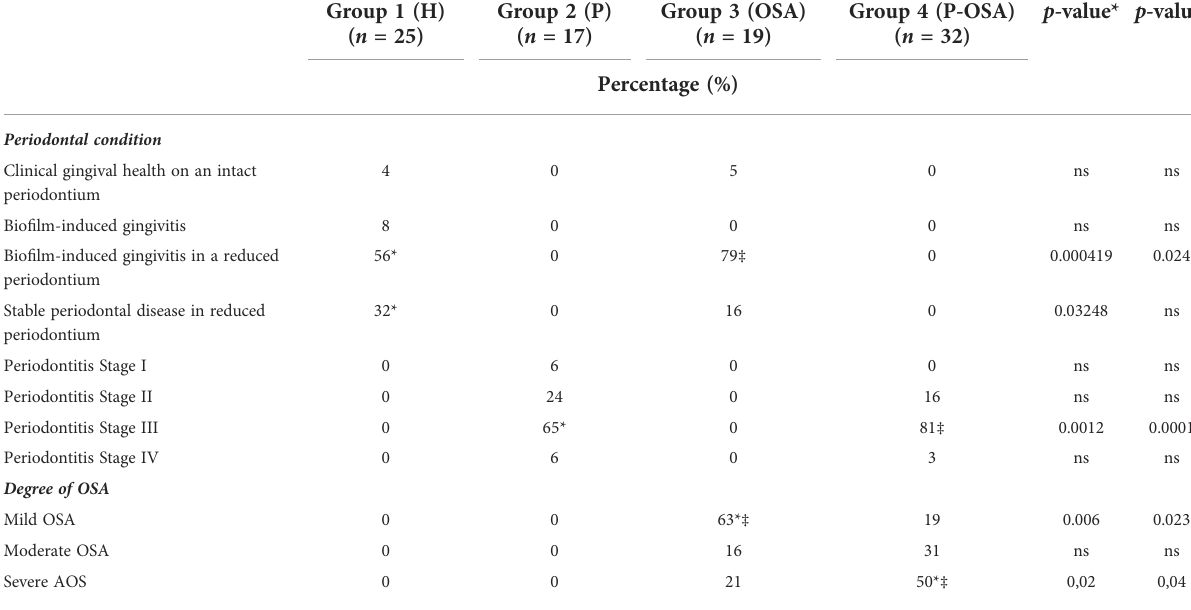
TABLE 2 Percentage of patients of each group according to periodontal condition and degree of OSA.